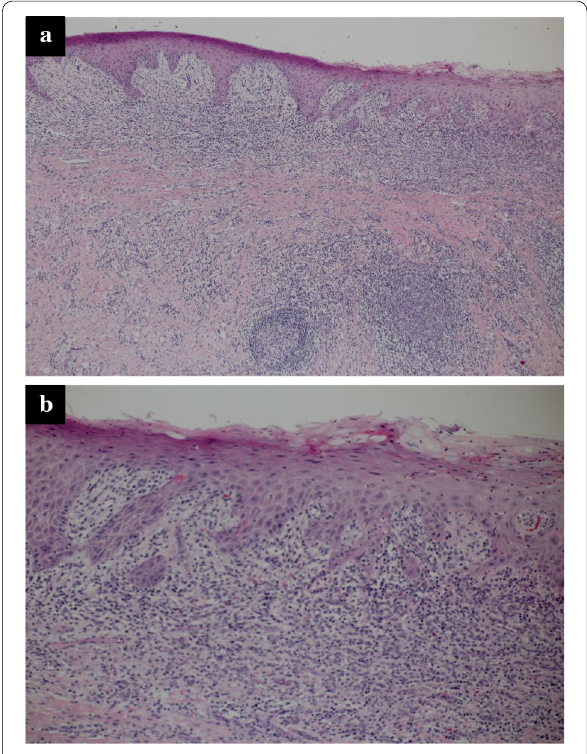
Fig. 4 Hematoxylin–eosin staining revealed histopathological features typical of oral lichen planus. a Magnification, Magnification, 100 ×